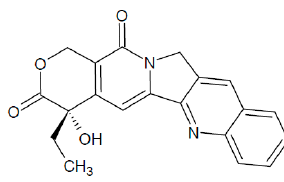
Figure 5. Camptothecin structure.